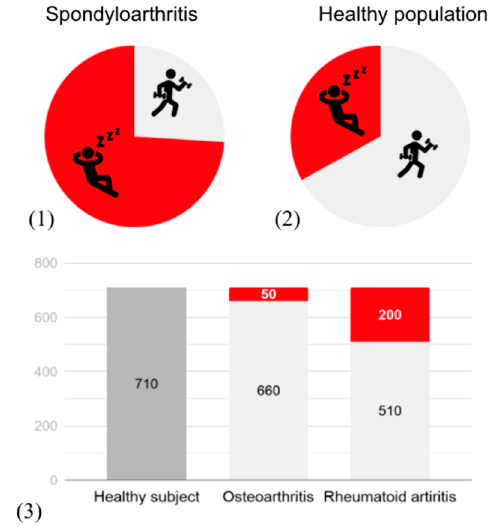
Figure 1. Physical activity level measured with questionnaire ( 1 ) ( 2 ) and with activity trackers ( 3 ). Y-axis = minutes of activity per week; the red part exposes the difference with the healthy population.